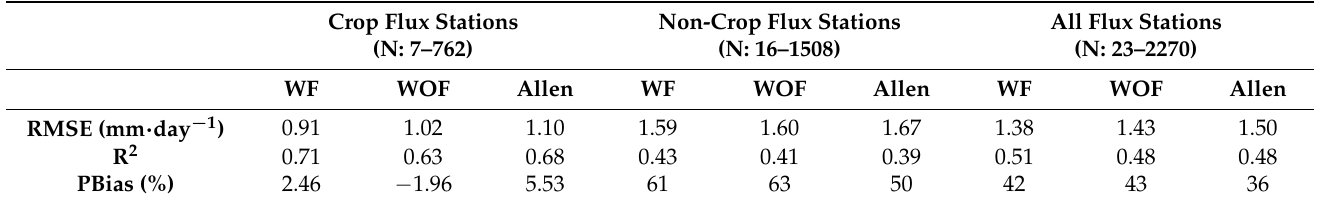
Table 3. Statistical summary of ET time series calculated using the different endmember estimation procedures vs. EC flux stations (N: number of